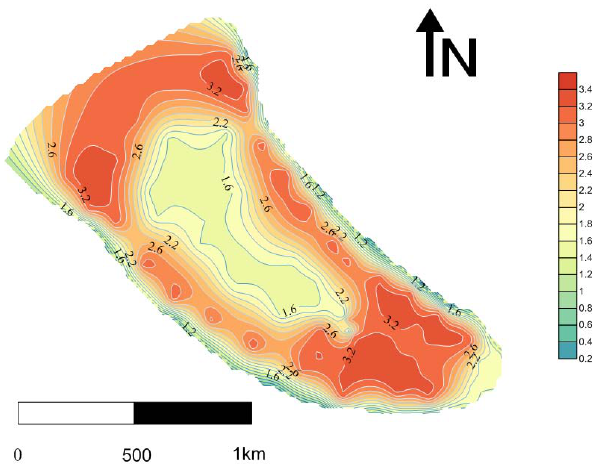
Fig. 6. Distribution of debris cover thickness on the terminus of Koxkar Glacier derived from multi-frequency ground penetrating radar. Redrawn from Wu and Liu (2012).